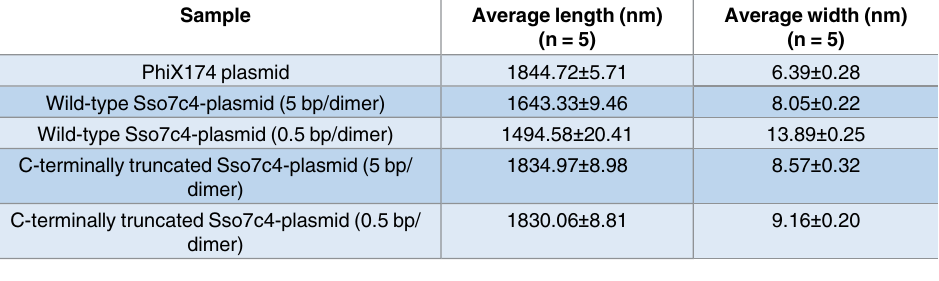
Table 2. Average lengths and widths of the plasmid and nucleoprotein complexes. EM images were measuredusing ImageJ